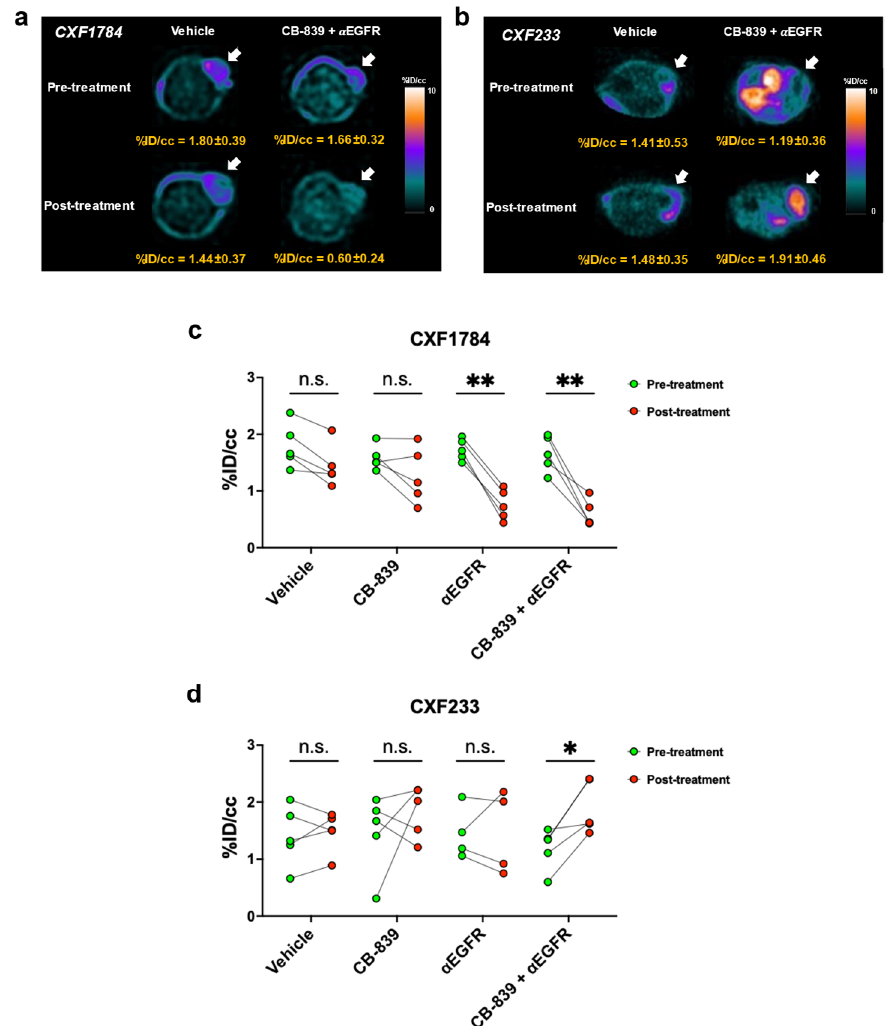
Figure 3. Preclinical [ 18 F]FSPG PET predicts treatment efficacy. Representative [ 18 F]FSPG-PET images of PDX murine models (( a ): CXF1784, ( b ): CXF233). Quantitative analysis of PET images of PDX tumors (( c ): CXF1784, ( d ): CXF233). Statistical significance is defined as follows: n.s. (not significant), * p < 0.05 and ** p <